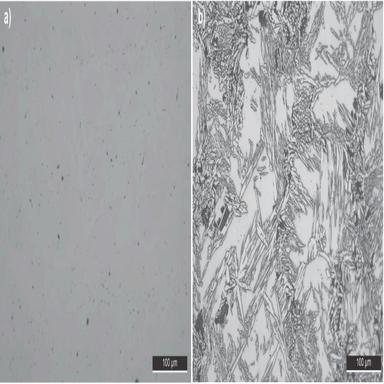
Sample SDSS-Nb as-cast condition, a) unetched image for inclusions determination, b) etched image showing microstructural features (KOH 30%, 1,5V for 30 s).